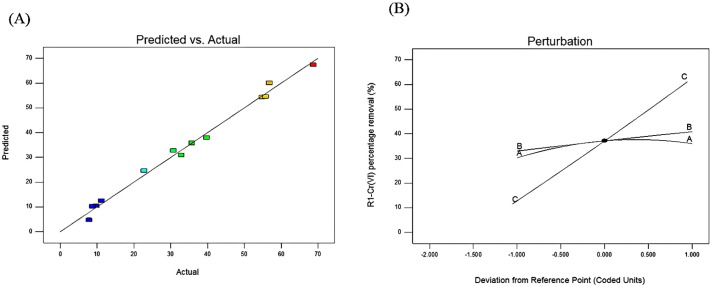
Actual versus predicted values for Cr(VI) percentage removal; The perturbation plot of factors biomass dosage (A), initial Cr(VI) concentration (B) and contact time (C).